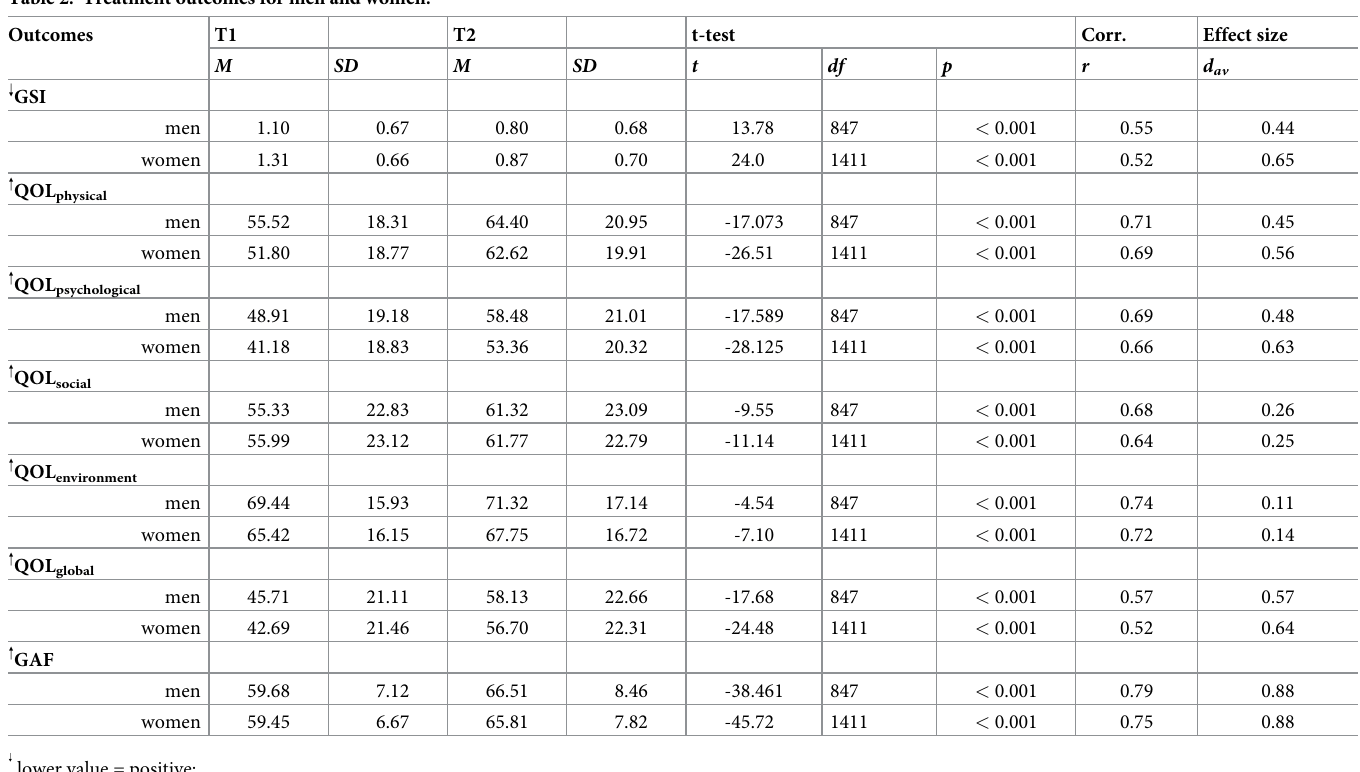
Table 2. Treatment outcomes for men and women.